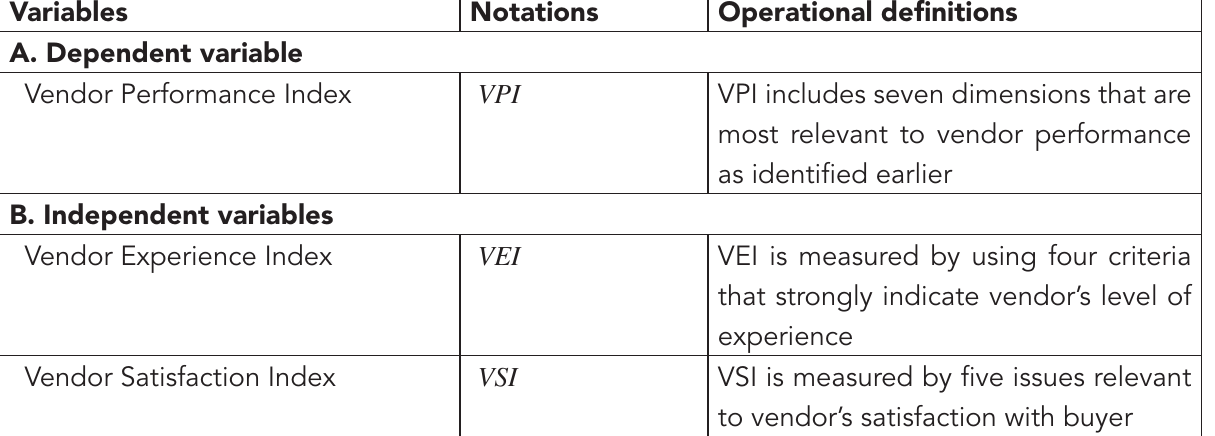
Table VI: Variables used in multiple regression